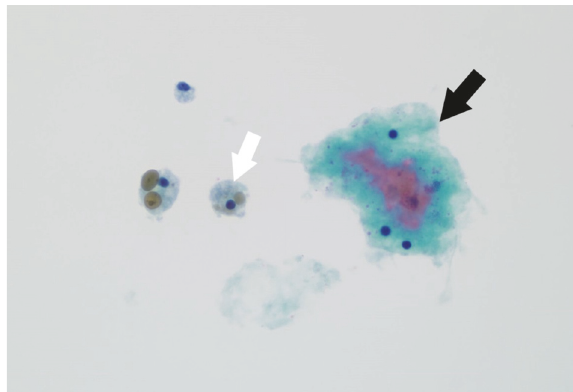
Figure 1: FNA cytology showing benign mesothelial cells (white arrow) and hemosiderin-laden macrophages (black arrow).